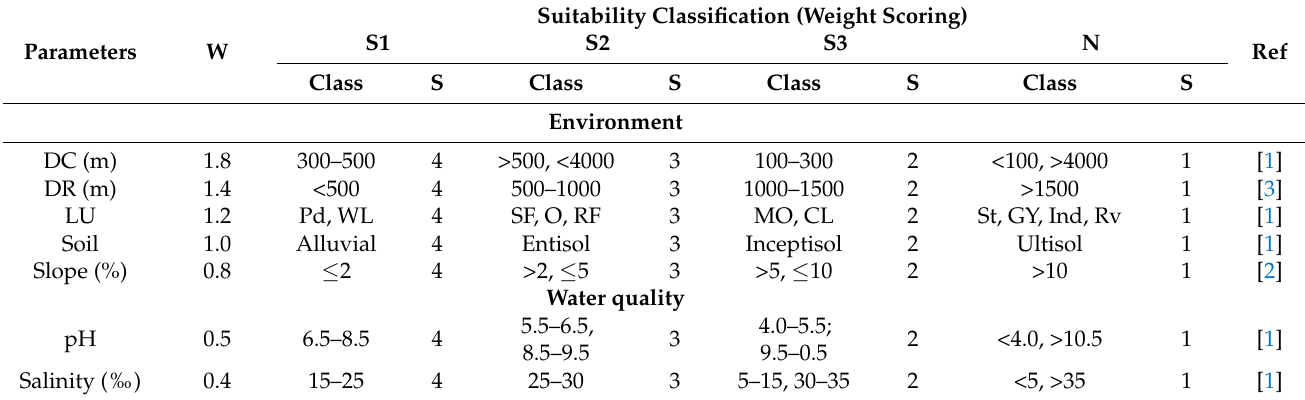
Table 2. Suitability matrices for fishpond